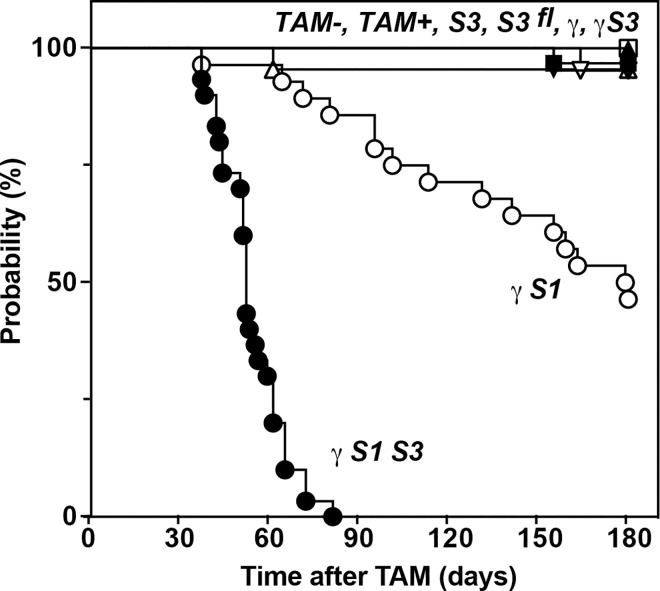
Rapid disease onset in mice lacking SOCS1 and SOCS3 in hematopoietic cells.Onset of disease in mice with hematopoietic cells lacking SOCS1 (γS1, ○) or both SOCS1 and SOCS3 (γS1S3, ●) compared with γ (▼),γS3 (▼), S3 (■), S3fl/fl (□) or control TAM+ (▲) or TAM- (△) mice. Mice were generated as described in S1 Fig. p<0.0005 for pairwise comparison of survival of γS1 with TAM- or γ and for γS1S3 with γS1 or γS3, Mantel-Cox Log-rank test, n = 19–30 mice per group.